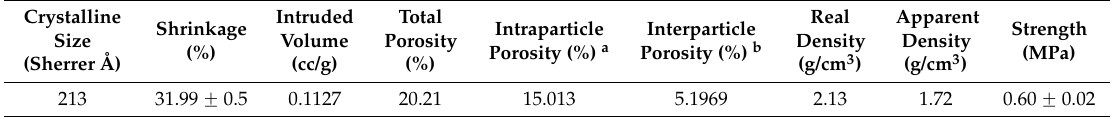
Table 1. Physical and mechanical properties of Nurse’s A phase.